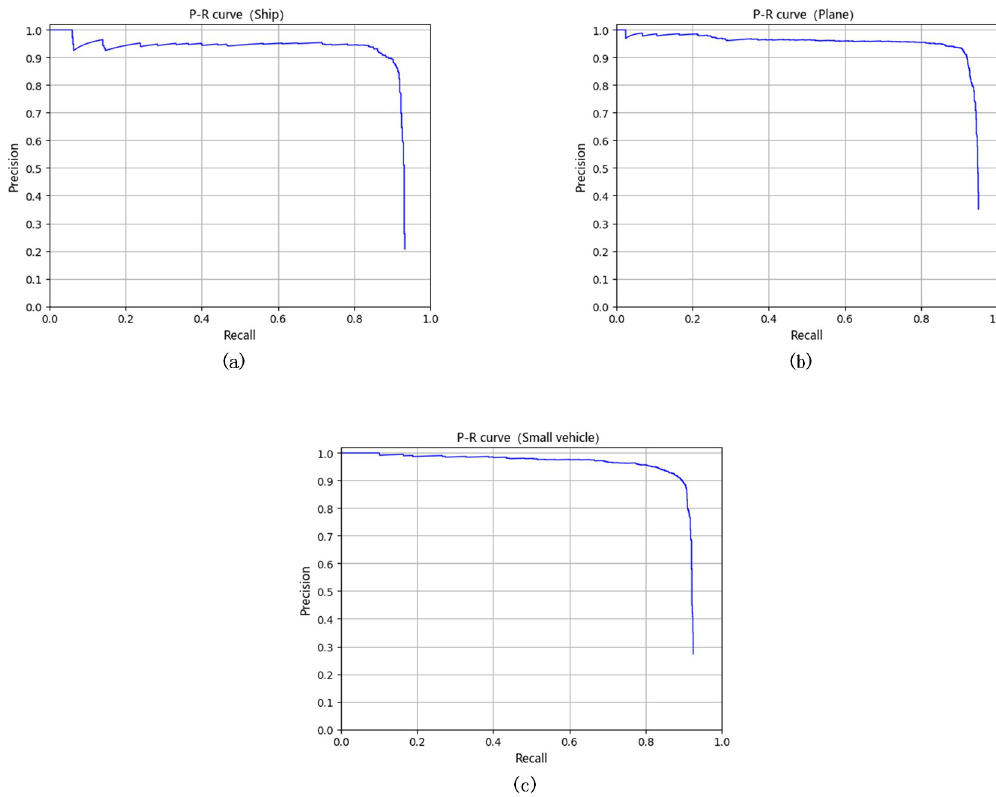
Fig 8. The P-R curve of our framework on DOTA different categories, (a) is the P-R curve on Ship, (b) is the P-R curve on Plane, (c) is the P-R curve on Small Vehicle.